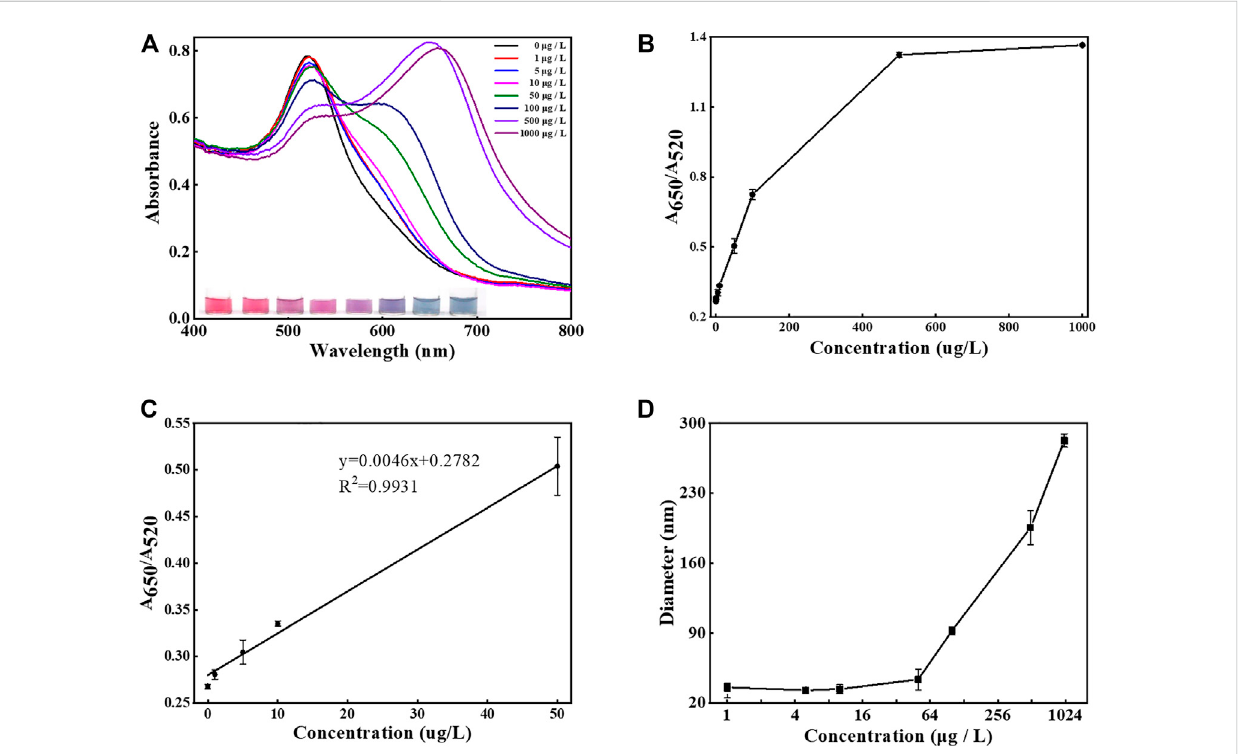
FIGURE 5 Sensitivitydetermination. (A) TheUV-Visspectraandimagesrecordedaftertheintroductionofmalathionwithconcentrationsfrom0to1,000 μ g/L. (B) The dependence of the values of A 650 /A 520 against various target concentrations from 0 to 1,000 μ g/L. (C) The linear relationship between the values of A 650 /A 520 and the concentration of malathion from 0 to 50 μ g/L. (D) The dependence of the DLS sizes of AuNPs in solution against various target concentrations from 0 to 1,000 μ g/L. The error bars represent the standard deviation of three independent measurements.